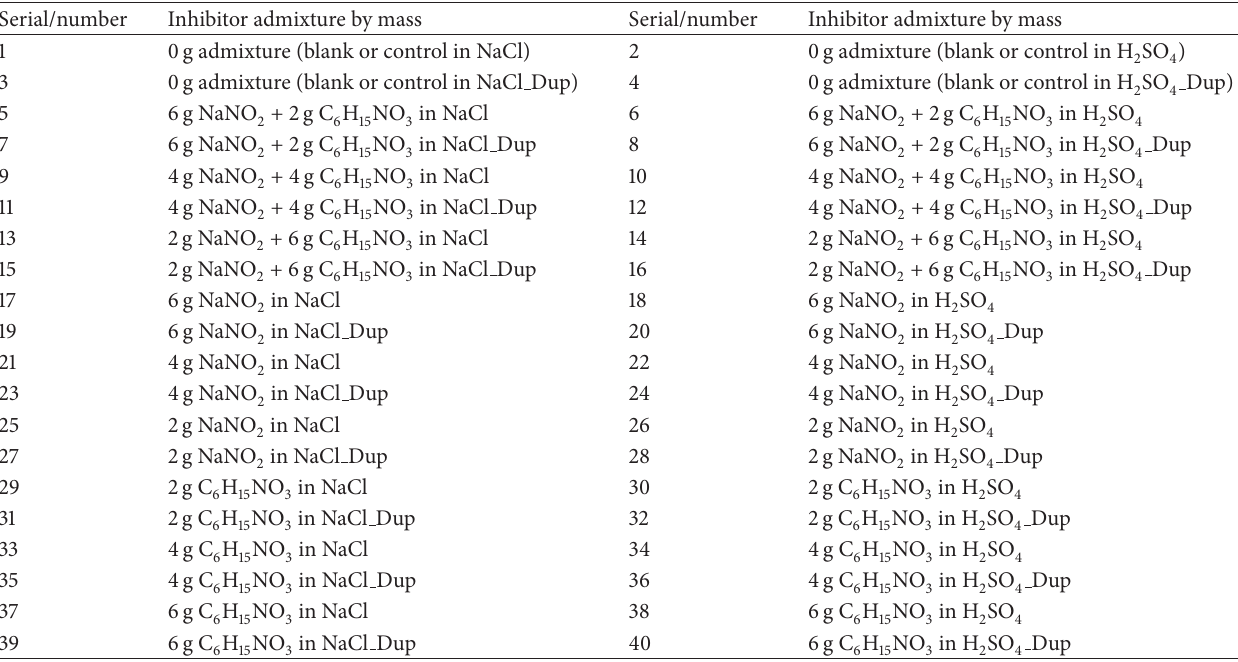
Table 1: Inhibitor admixtures by mass in the steel reinforced concrete